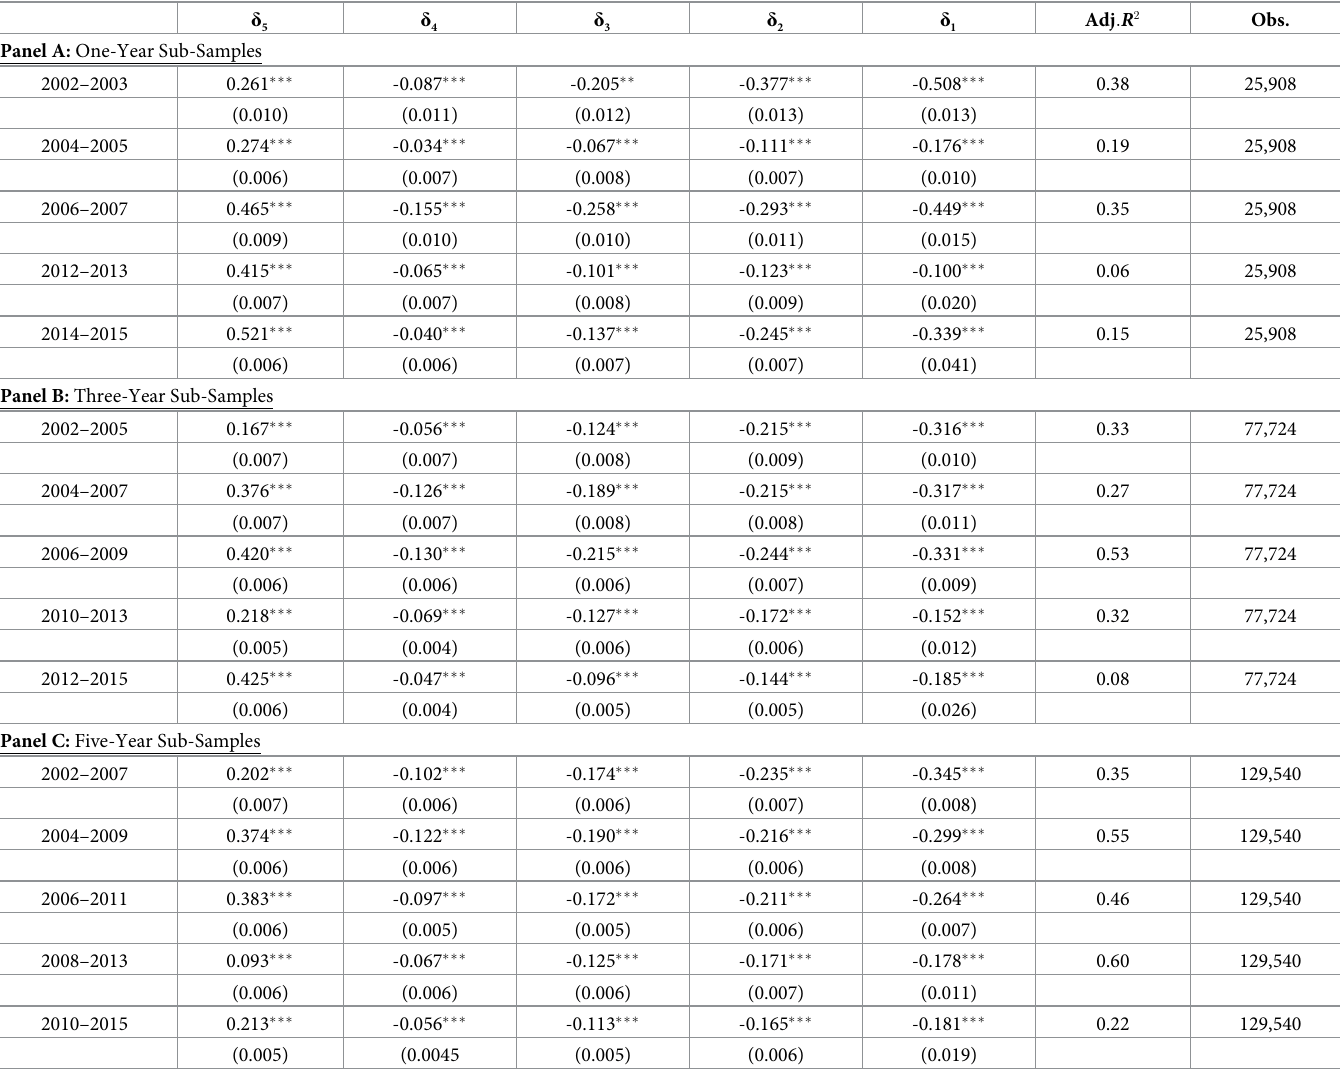
Table 5. Panel regression results derived from ratings based on EU-E ( λ = 0.25) where the Sharpe ratio measures out-of-sample